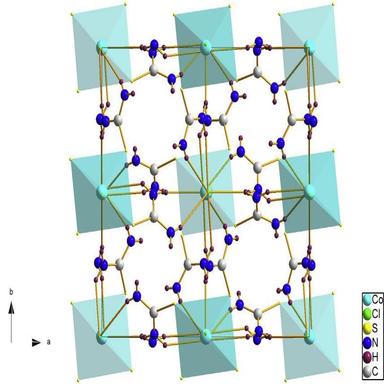
Projection of the inorganic matrix in the (a, b) plane.